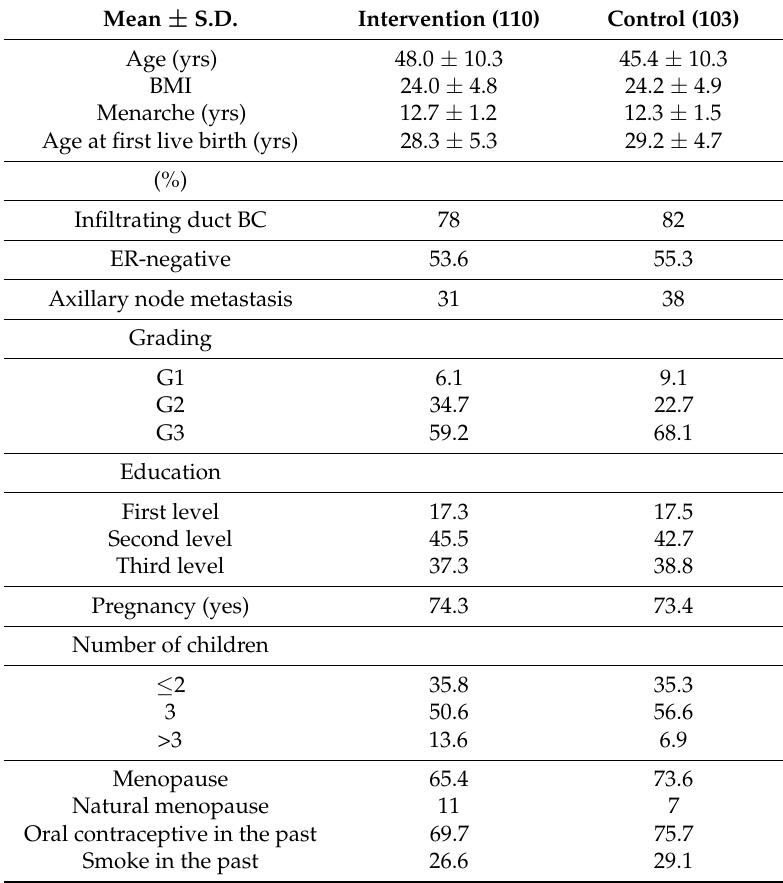
Table 1. Baseline characteristics of the study population (213 women). Mean ±